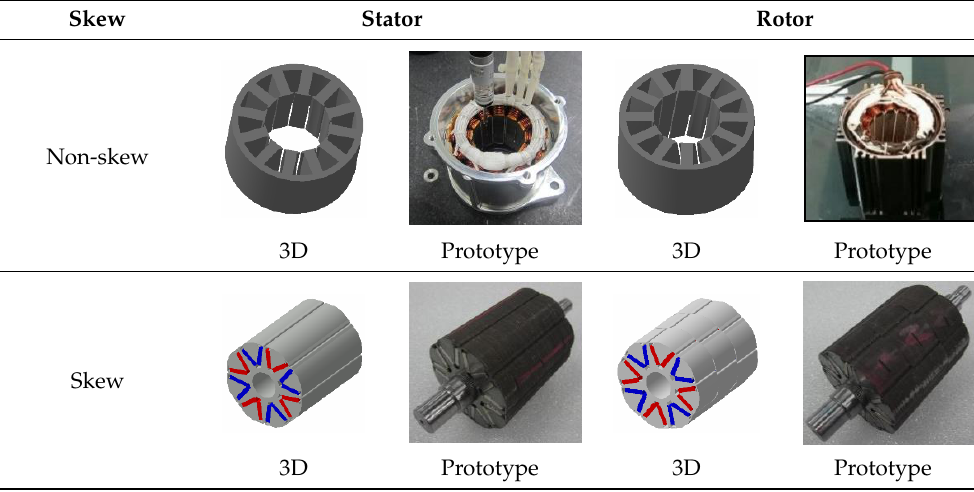
Table 2. 3D and prototypes with the different skew designs.